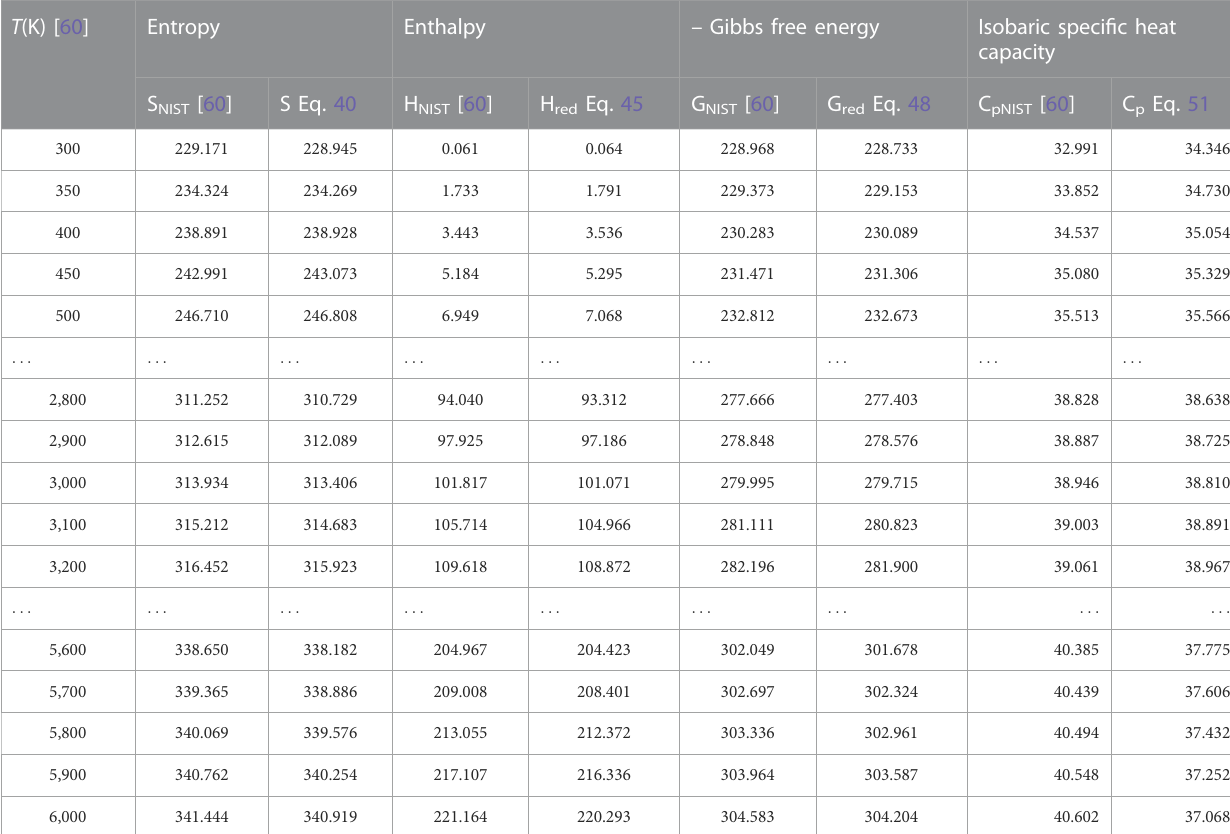
TABLE 5 Computed data on molar entropy (J mol − 1 K − 1 ), reduced enthalpy (kJ mol − 1 ), reduced Gibbs free energy, and isobaric speci fi c heat capacity for the BrF (X 1 Σ + ) molecule. N p =